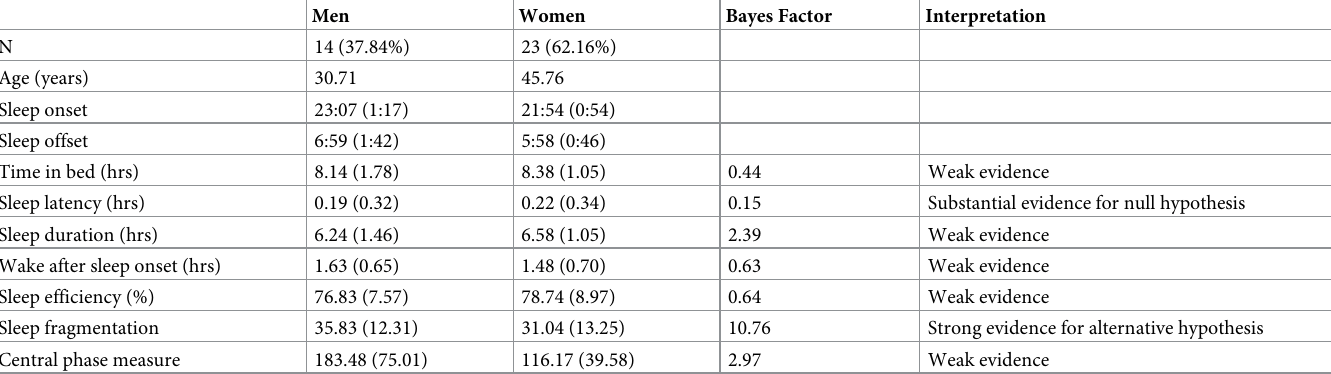
Table 3. Descriptive statistics: Mean (SD) and statistical tests for gender differences in sleep quotas.